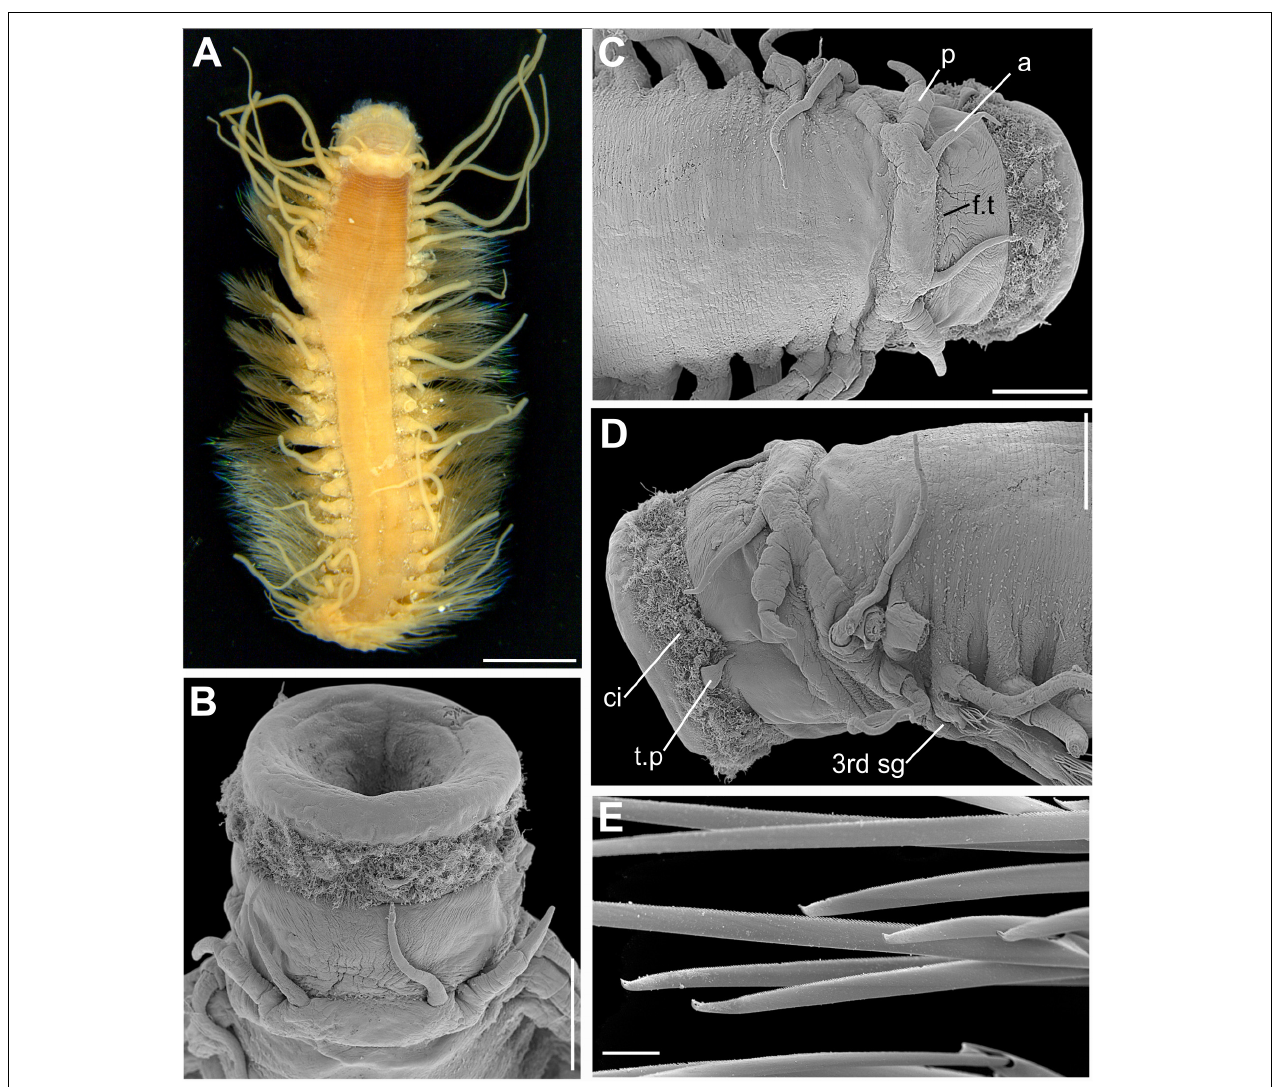
FIGURE 10 | (A–E) Sirsoe alucia sp. nov. (A) complete specimen, dorsal view; (B) anterior end, dorsal view with proboscis extended; (C) anterior end, dorsal view; (D) anterior end, lateral view; (E) detail of neurochaetae. 3rd sg, third segment; a, lateral antenna; ci, ciliation; f.t, frontal tubercle; p, palps. Scales: (A) 1.5 mm; (B–D) 500 µ m; (E) 20 µ